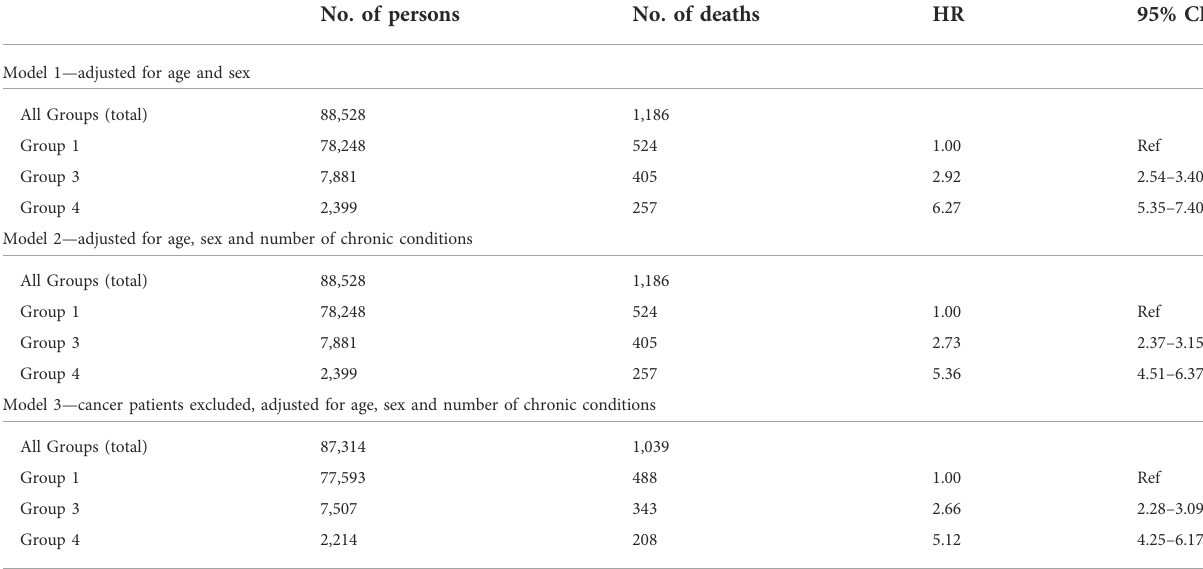
TABLE 3 The relationship between long-term use of hypnotics-sedatives, hypnotics-sedatives/opioids, morbidity and mortality. Cox proportional hazards regression is used for models 1 – 3.